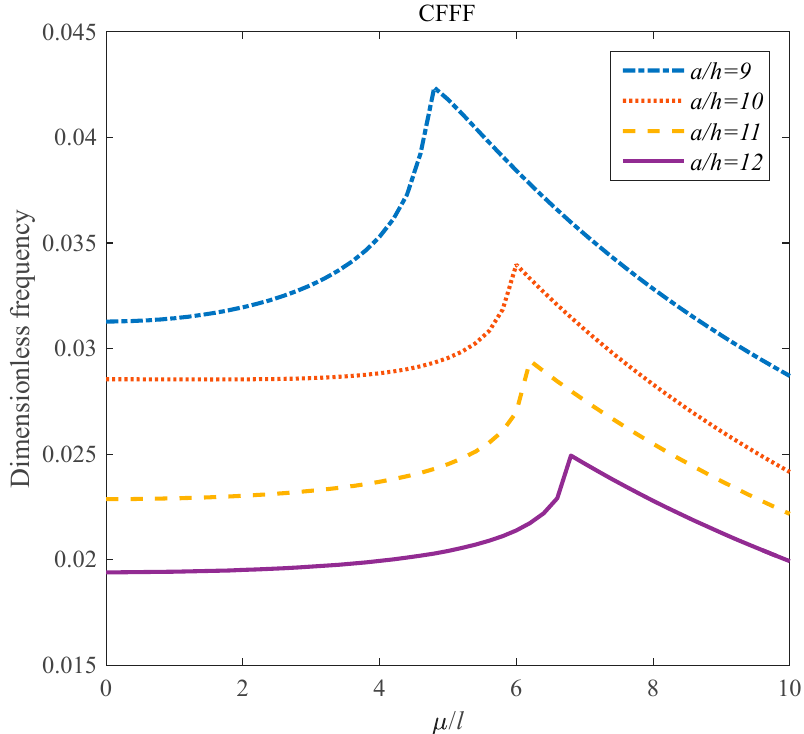
Figure 5. The e ff ects of a / h and µ / h on the frequency for the CSFS boundary conditions with a / b = 5, Figure 5. The effects of a/h and μ /h on the frequency for the CSFS boundary conditions with a/b = l = h / 5, ∆ T = 100K, NL = 10, g_GPL = 0.5%, and GPL-x. 5, l=h/5, ∆ T=100K, NL = 10, g_GPL= 0.5%, and GPL ‐ x.